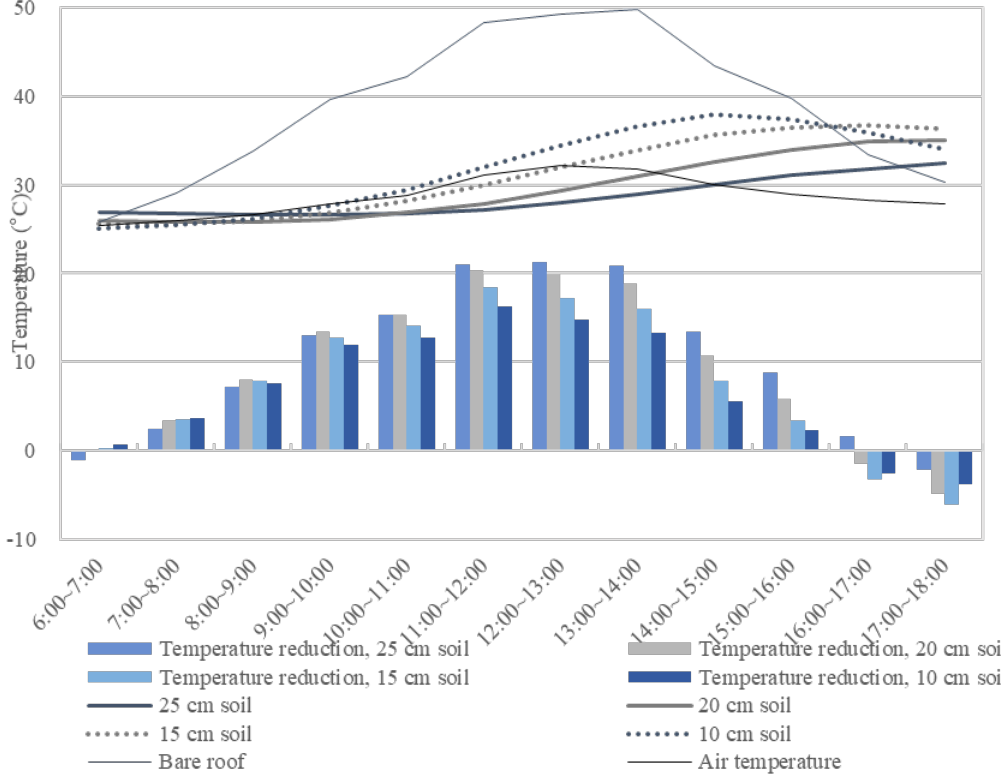
Figure 7. Temperatures and temperature reductions in the cases of 10, 15, 20, and 25 cm garden-soil roofs without plants (14 May 2017 05:59:44 to 14 May 2017 17:49:44).